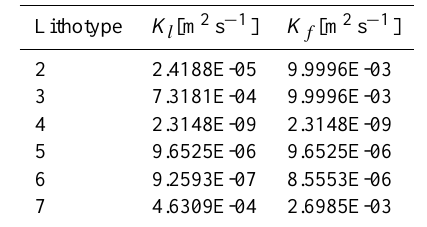
Table 2. Hydraulic conductivity for each unit; K l = K lithotype. K f = K lithotype near the fault. For some lithotypes K f > K l , so the faults show a conduit